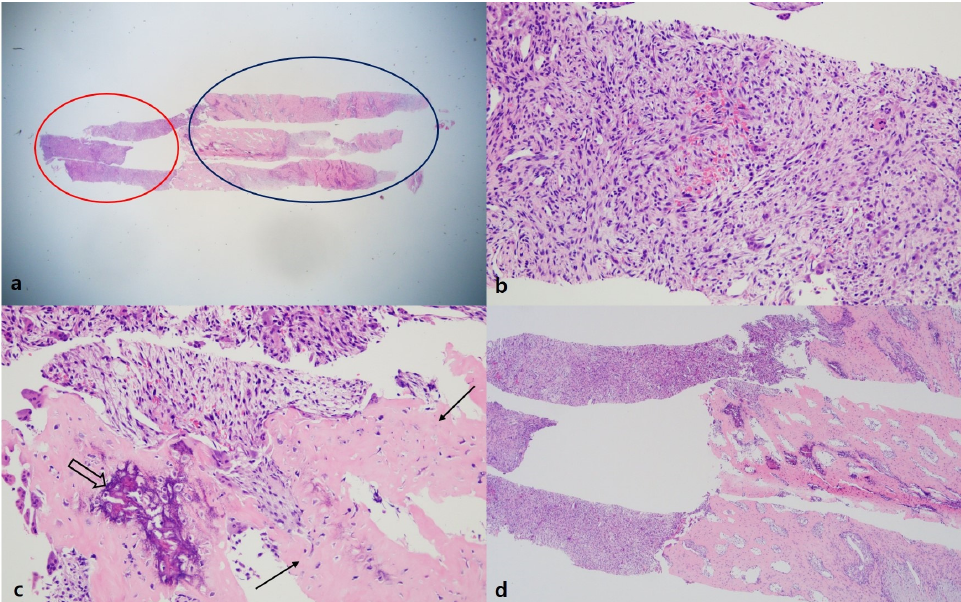
Figure 5. Histologic findings of biopsy (H&E stain). ( a ) On scanning view (x25), the biopsied tissue had two components, including a hypercellular area (left portion of the tissue, red-colored circle) and highly sclerotic area (right portion, blue-colored circle). ( b ) The cellular area showed ovoid to spindle-shaped cellular proliferation in edematous background. Additionally, there were extravasated erythrocytes, and the stroma had increased vascularity (x200). ( c ) The area, which was observed as hypersclerotic on scanning view, showed woven bone formation (arrows) and had mineralization (empty arrow) (x200). ( d ) The central area had a transition of the hypercellular component with woven bone formation (x40). Overall, the histologic findings were compatible with MO.